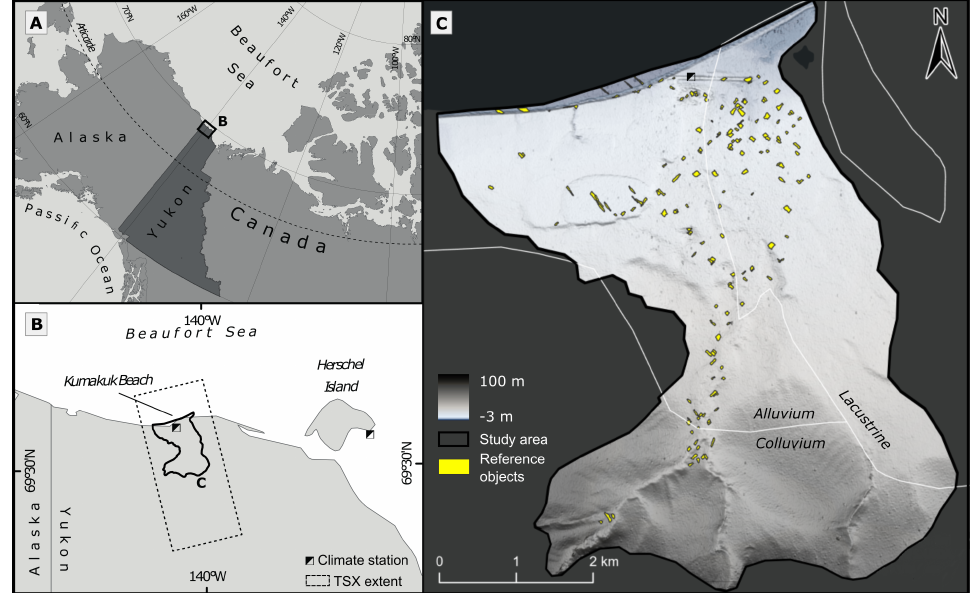
Figure 1. ( A ) Overview of Northwestern Canada. ( B ) Beaufort Coast Area, with TerraSAR-X (TSX) extent and climate stations. ( C ) Komakuk Beach study area with the reference objects, boundaries of deposits (white line), and terrain. DEM(s) courtesy of the Polar Geospatial Center